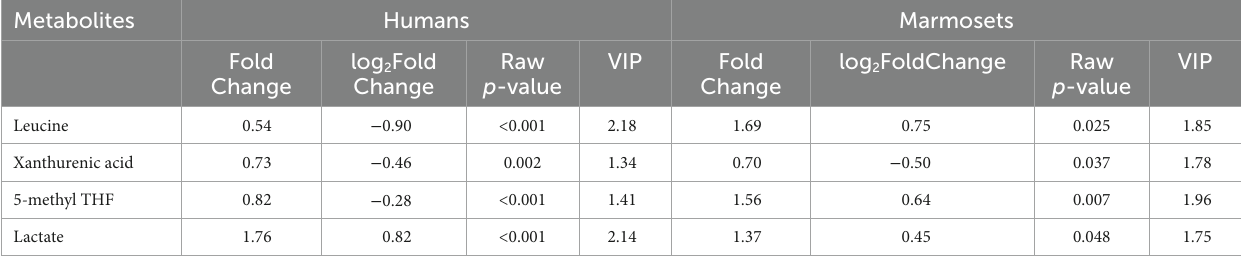
TABLE 2 Fold Change, log 2 Fold Change, Raw p -value and VIP value of four common differential metabolites in anesthetized human serum and marmoset monkey brain tissue. Metabolites Humans Marmosets Fold log Fold 2 Change Change